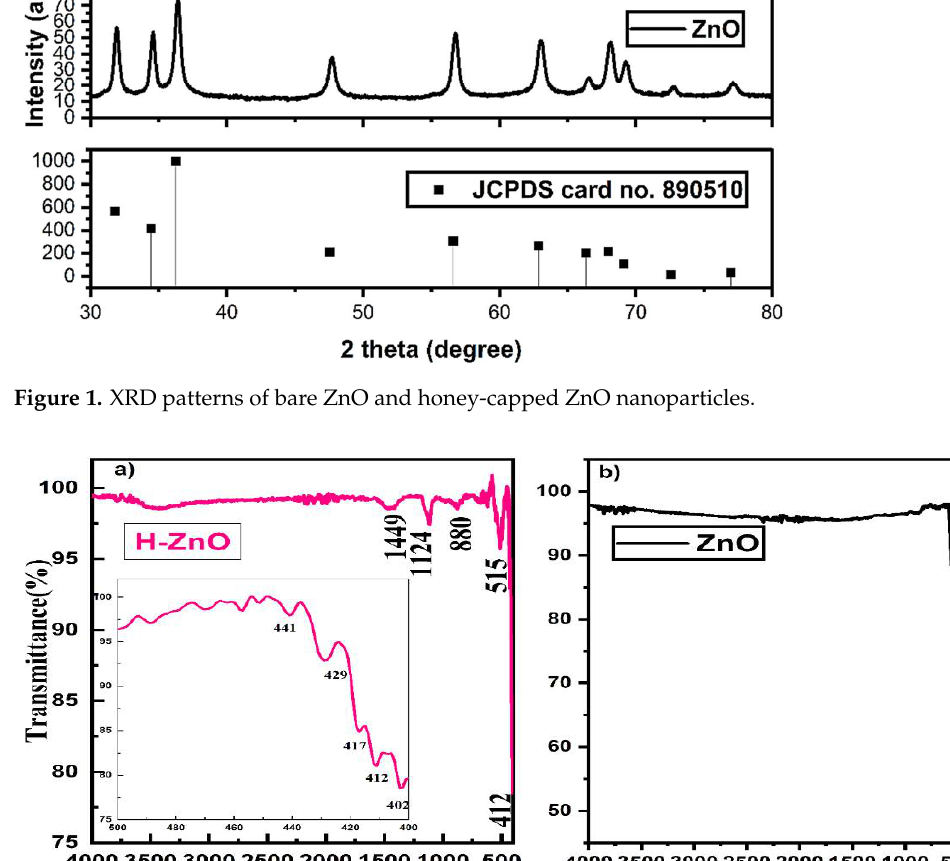
Figure 1. XRD patterns of bare ZnO and honey-capped ZnO nanoparticles.